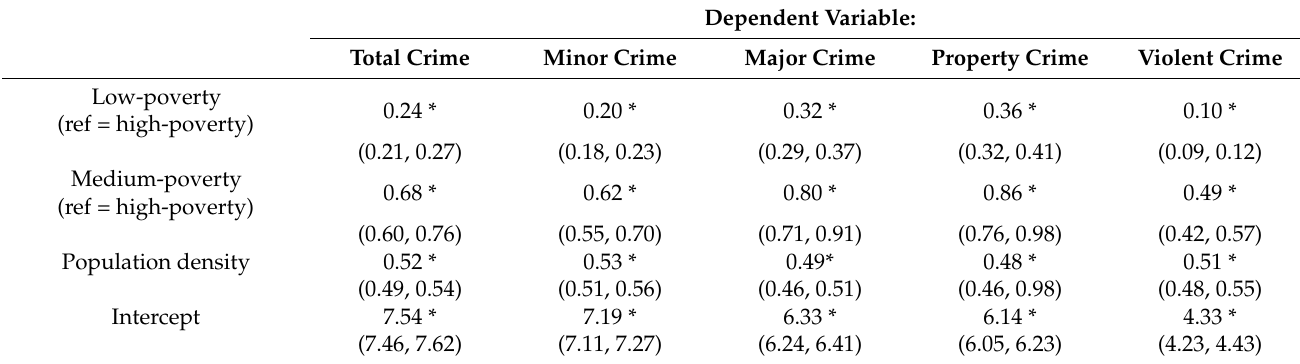
Table 2. Mutually adjusted models for police-reported crime types and school poverty. Dependent